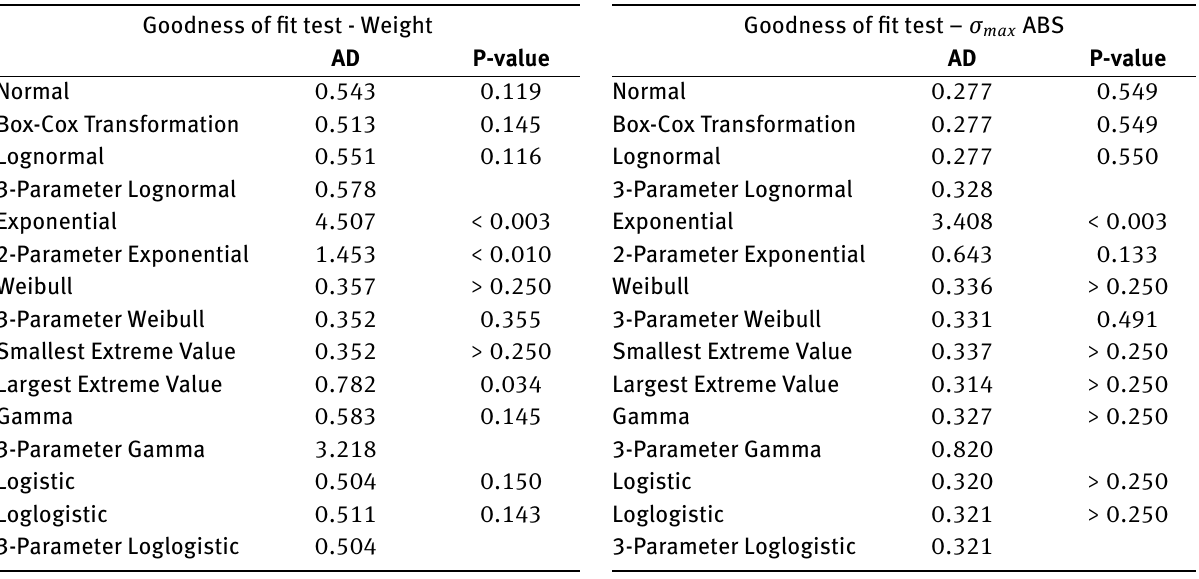
Table 6: Individual distribution identification for the weight of spec- imens.